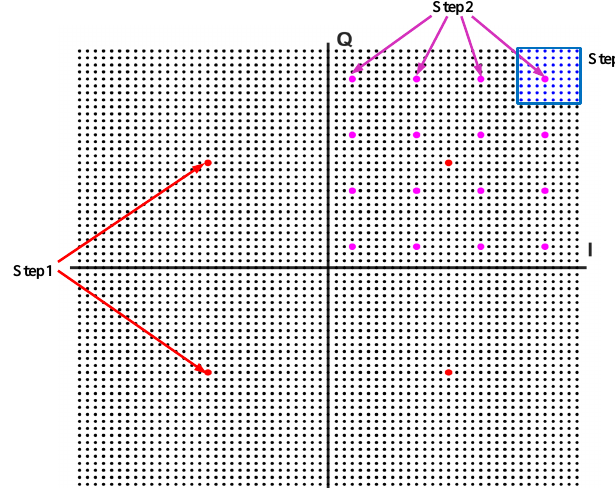
Figure 14. Schematic diagram of self-jamming cancellation